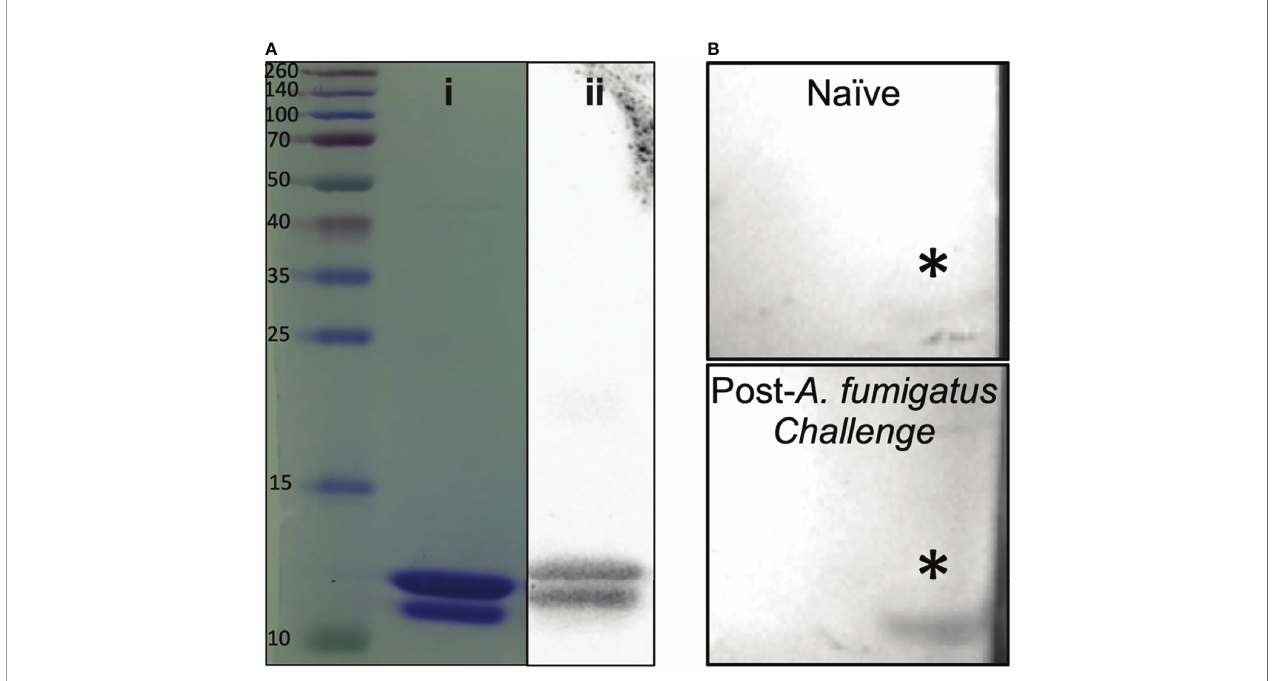
FIGURE 1 | AF.KEX1 puri fi cation and humoral responses following A. fumigatus challenge. (A) Puri fi ed AF.KEX1 protein by ( i ) Coomassie and ( ii ) anti-histidine Western blot. (B) Western blots of recombinant AF.KEX1 using plasma from a single mouse prior to and following A. fumigatus challenge. AF.KEX1 bands are indicated by